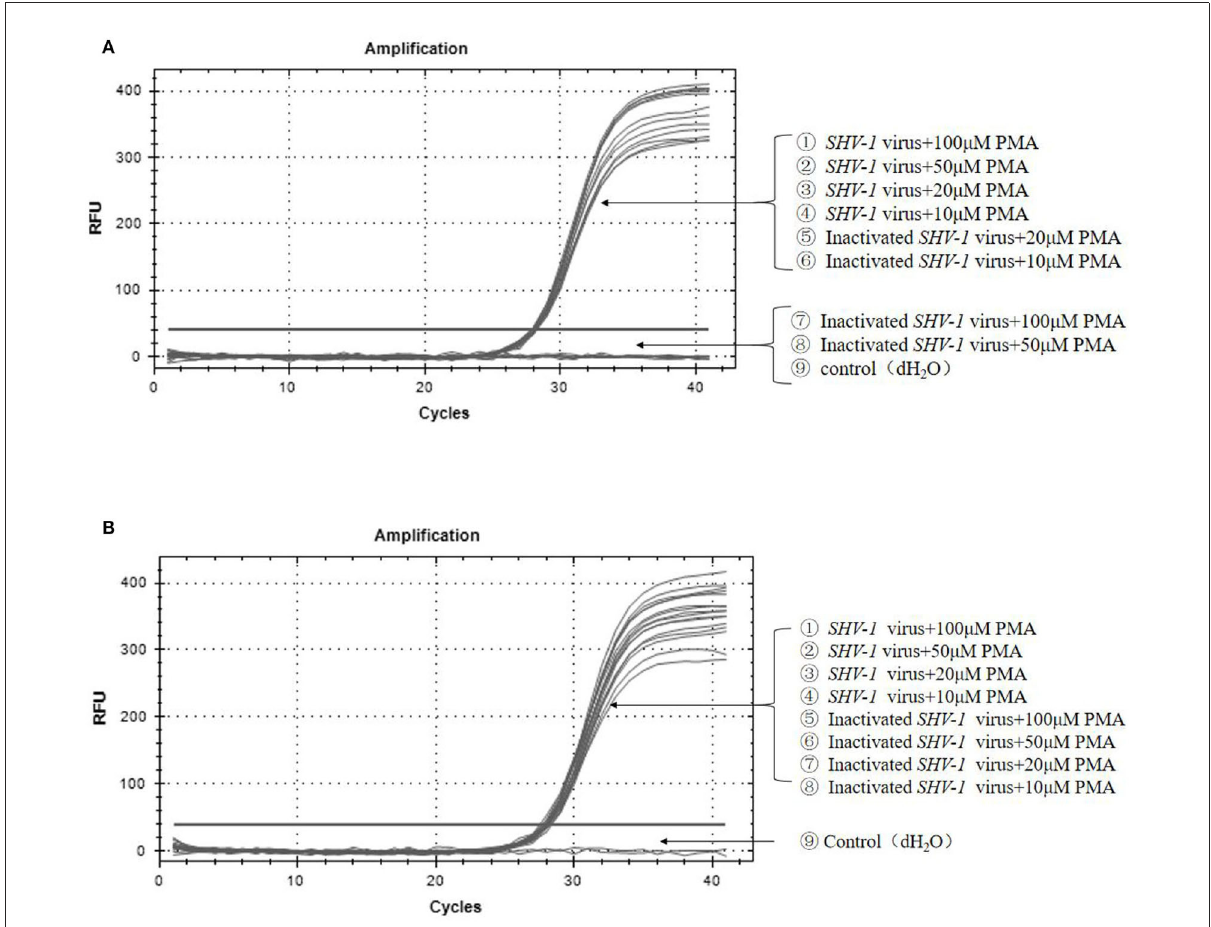
FIGURE4 Effectiveness of different virus dilutions on SHV-1 PMA-qPCR. (A) Different PMA concentrations on SHV-1 virus qPCR. ‹ - fl the different concentration PMA + SHV-1 virus group; (cid:176) - ‡ the different concentration PMA + inactivated SHV-1 virus group; · the control group (dH 2 O); (B) different primer pairs PMA-qPCR of porcine SHV-1 virus. ‹ - fl the different concentration PMA + SHV-1 virus group; (cid:176) - ‡ the different concentration PMA + inactivated SHV-1 virus group; · the control group (dH 2 O).